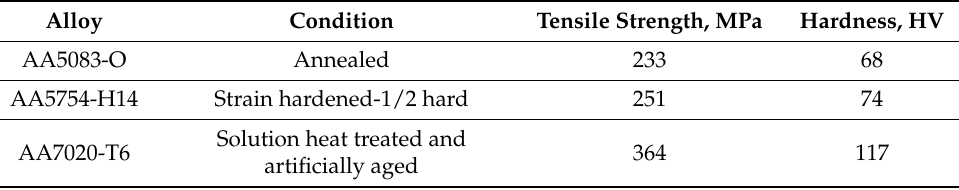
Table 2. Mechanical properties of the aluminum alloys AA5083, AA5754 and AA7020.